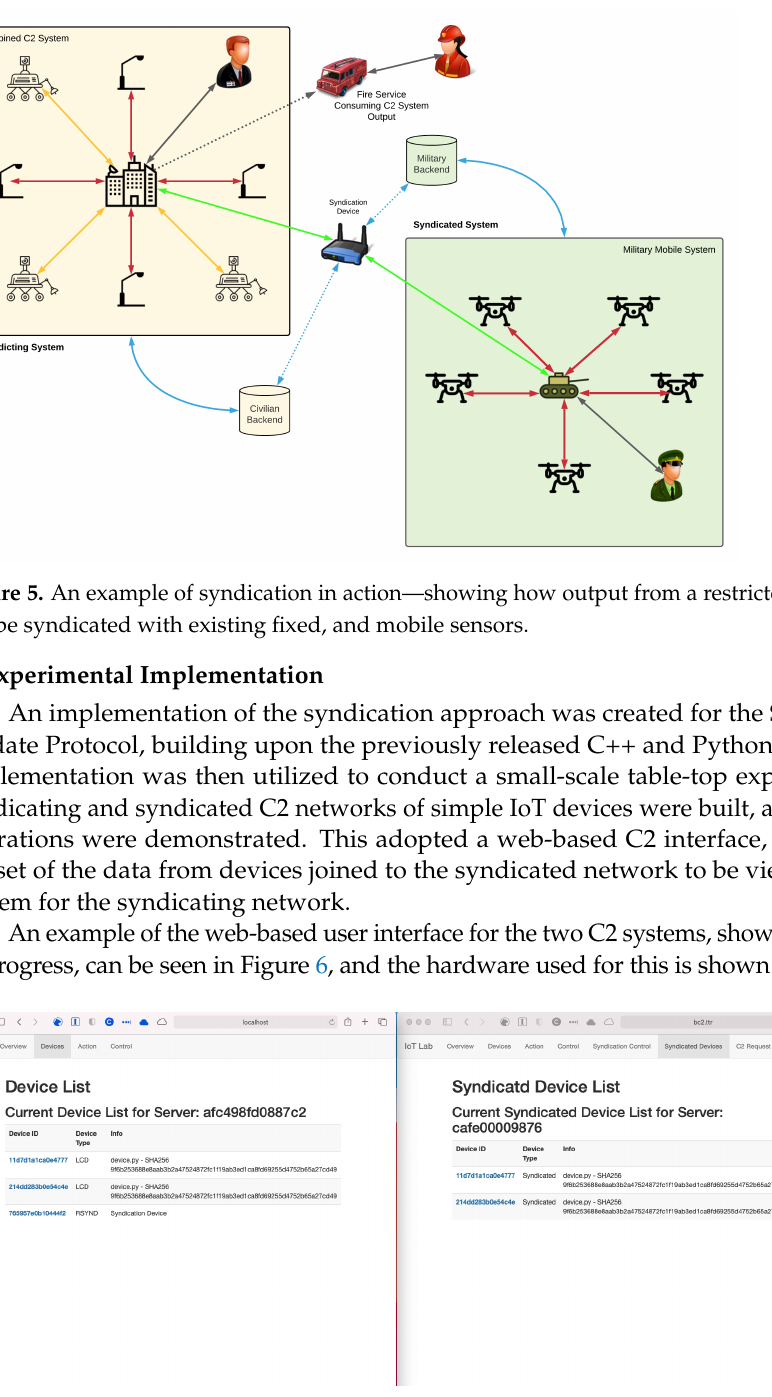
Figure 6. A screenshot from the example implementation of the syndication in